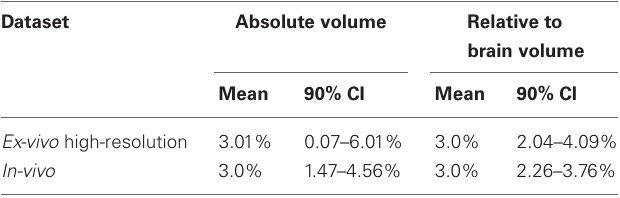
Table 3 | The relative abilities of the in-vivo and high-resolution ex-vivo experiments to accurately estimate the slope (with an expected final change of 3%) of an induced change given as means and 90% confidence intervals (CI). See also Figure